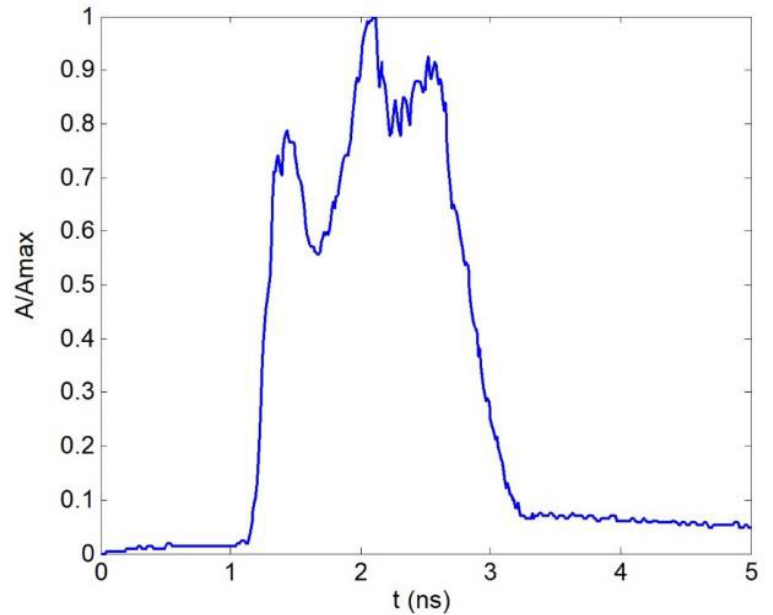
Figure 20. Optical pulse response at the output of MMF.